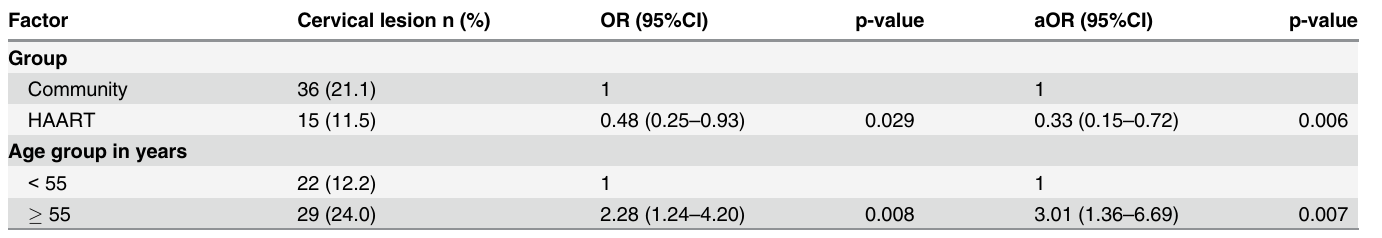
Table 2. Logistic regression model of factors associated with cervical disease.